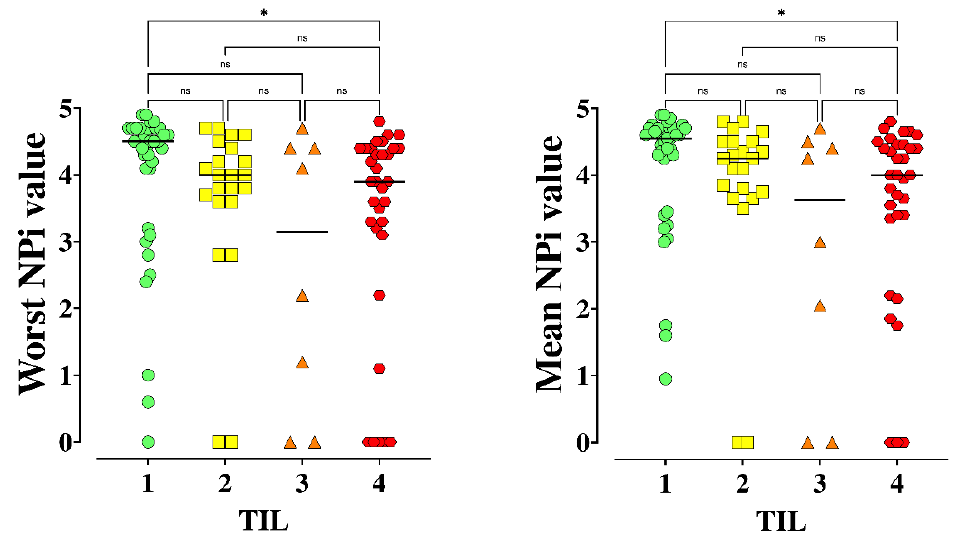
Figure 3. Worst and mean Neurological Pupil Index (NPi) values across different Therapeutic Intensity Level (TIL) ranges. * p < 0.05 for post hoc analysis among groups. NS = not statistically significant. The Kruskal Wallis test, with Dunn-Bonferroni post hoc analysis, was used. Differences of patients according to high intensity (TIL-4) or other TIL values are shown in Supplemental Tables S3 and S4. Also, worst and mean NPi on admission were significantly different when analyzed across different predicted UO and mortality rates according to the TBI-IMPACT Database (Figures 4 and 5).